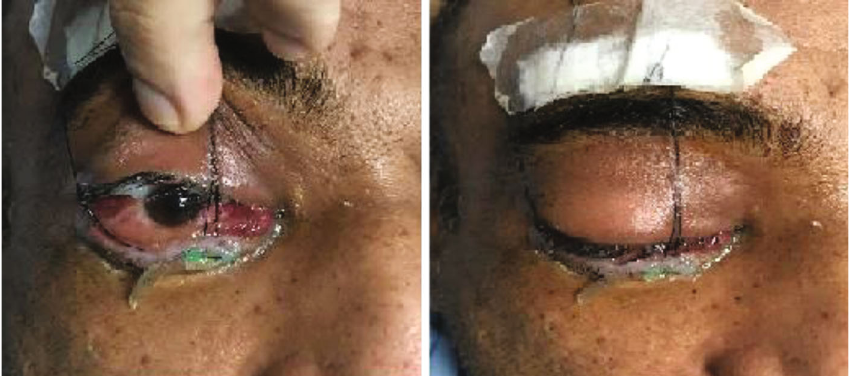
Figure 3: Rt side preorbital edema and